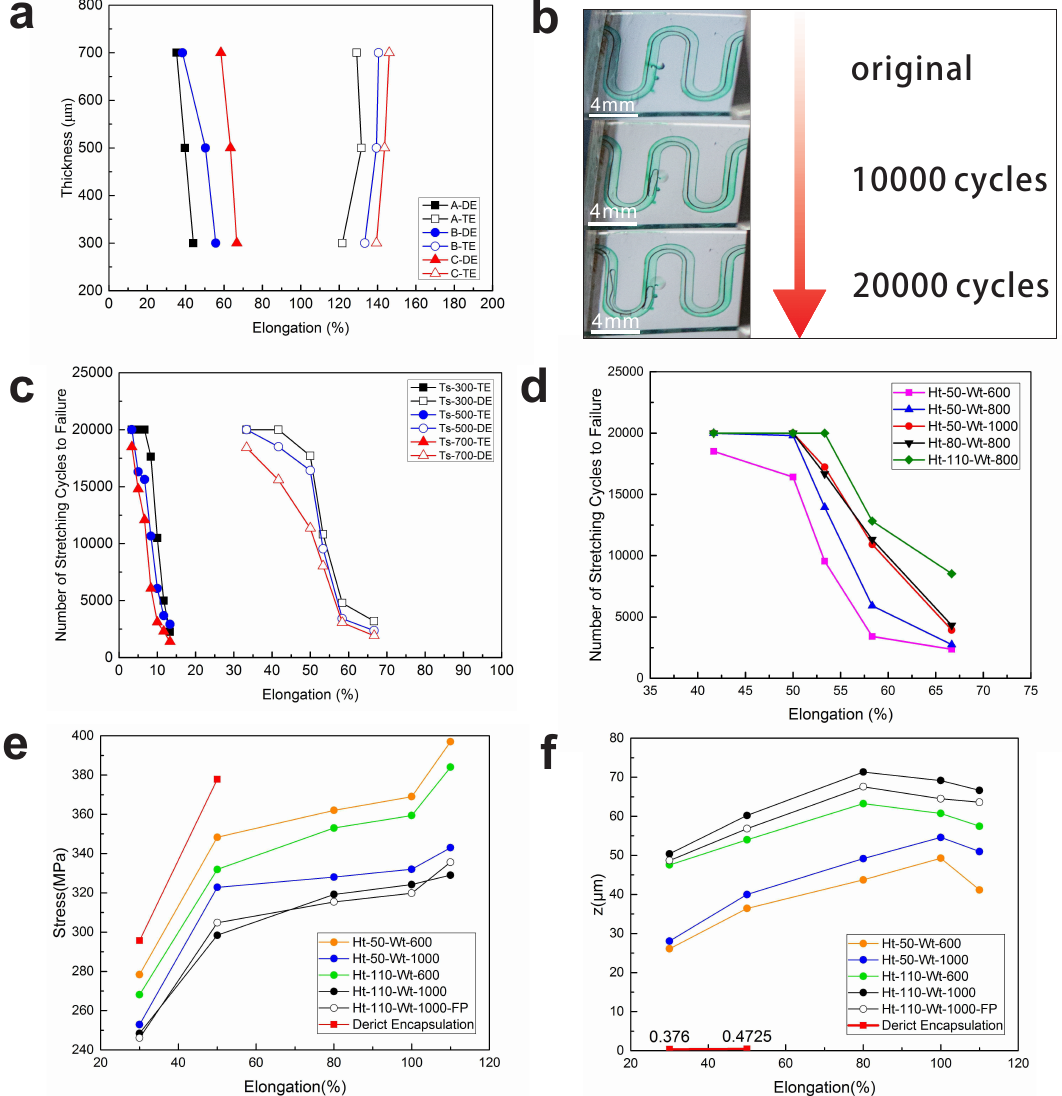
Figure 3. ( a ) Maximum stretchability when the serpentine (different patterns) encapsulated in different technologies with different sample thicknesses Ts from 300 to 700 µ m and the width of these samples is 600 µ m. ( b ) Reversibility illustration of serpentine in tunnel encapsulation (Ht = 100 µ m, Wt = 1000 µ m, Ws = 1 cm, Ts = 500 µ m). ( c ) Number of stretching cycles to failure when the serpentine encapsulated in different technologies with different sample thicknesses Ts from 300 to 700 µ m and the width of these samples is 600 µ m. ( d ) Experimental results for different width and height of tunnel in system (Ts = 500 µ m). ( e , f ) FEA predictions on stress and relative displacement in z direction of serpentine interconnects under